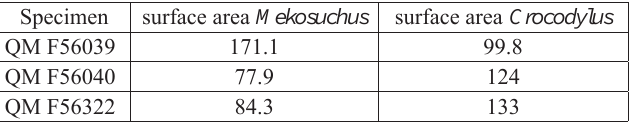
Table 2. Measured surface areas (in mm 2 ) of the spinous process in vertebrae referred to Mekosuchus whitehunterensis compared to those in Crocodylus johnstoni (AR 17683).